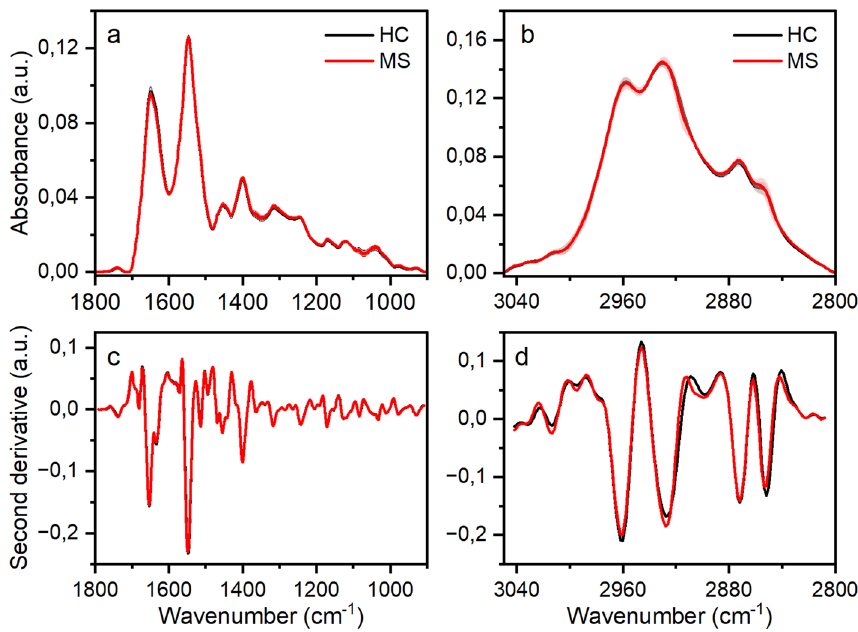
Figure 1. ATR-FTIR average spectra, recorded at 25 °C, of plasma samples from 40 HC (black line) and 45 MS (red line) subjects. Mean absorbance spectra in the ( a ) fingerprint region, 1800–900 cm −1 and ( b ) high region, 3050–2800 cm −1 . In the ( c , d ) panels are shown the second derivative vector normalized